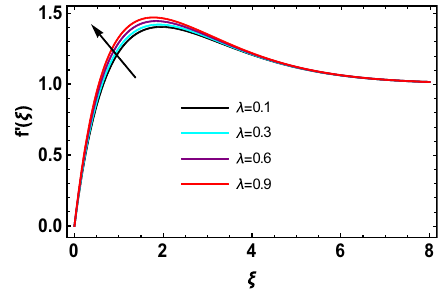
Figure 7. Impact of (cid:31) upon f ′ (ξ) .